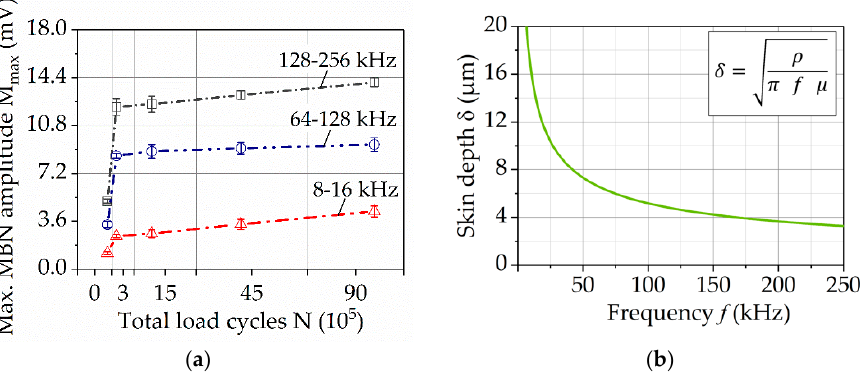
Figure 13. ( a ) Maximum amplitude of the BN profile curve for different filter bandpass frequencies, using FracDim; ( b ) Correlation of bandpass frequencies and depth, calculated based on the equation for skin effect.